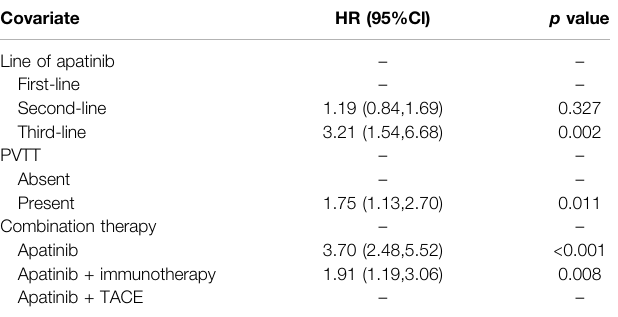
TABLE 3 | Multivariable Cox proportional hazard models of progression. TABLE 4 | Multivariable Cox proportional hazard models of